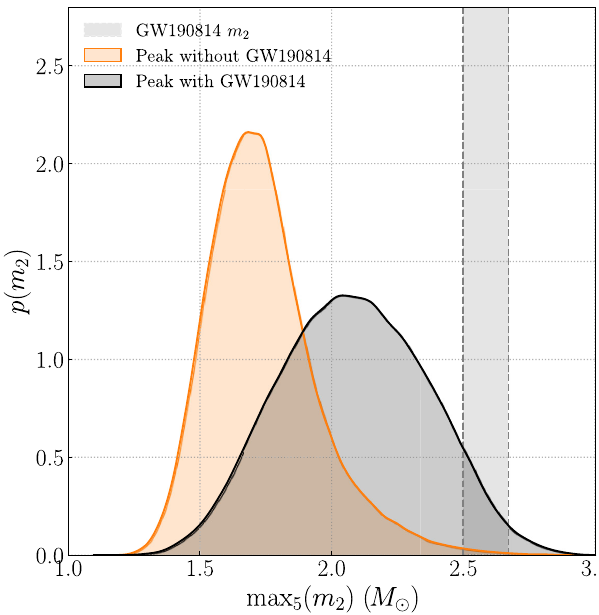
FIG. 8. Comparison between GW190814 ’ s secondary compo- nent and the largest secondary mass in the observed BNS and NSBH population. The P EAK model is fit to the population including (respectively, excluding) GW190814. The predicted distribution of the largest secondary mass max 5 ð m 2 Þ observed after five detections — two BNSs and three NSBHs — is shown in orange (blue). The shaded region represents the 90% credible interval of the posterior distribution for the mass of GW190814 ’ s secondary component. GW190814 ’ s m 2 is a 0.2%-level outlier from the rest of the observed population of NS secondaries.